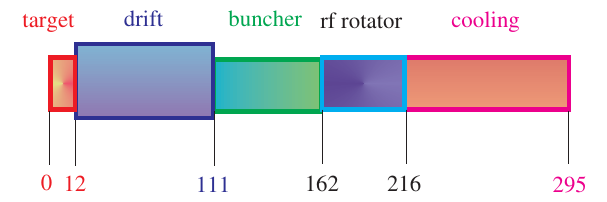
FIG. 4. (Color) Overall layout of the front end.FIG. 3. (Color) Longitudinal phase space after the drift section.